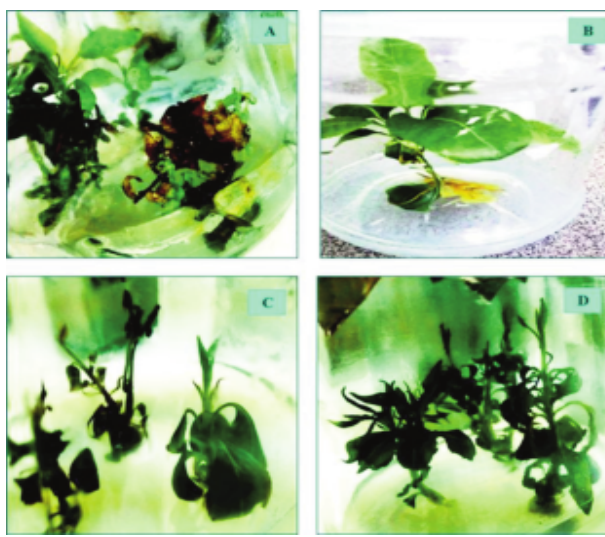
Fig. 1 ­ Contaminated shoots in vitro culture (A). Contaminated shoot after sub­culturing on media without cefixime